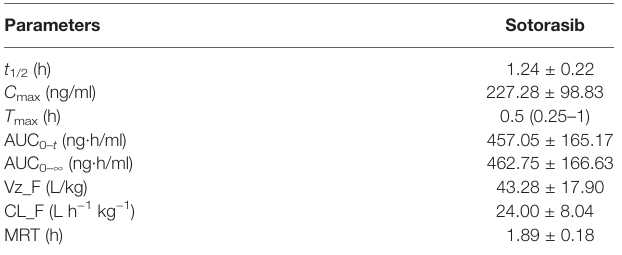
TABLE 4 | Pharmacokinetic parameters of sotorasib in rats ( n =